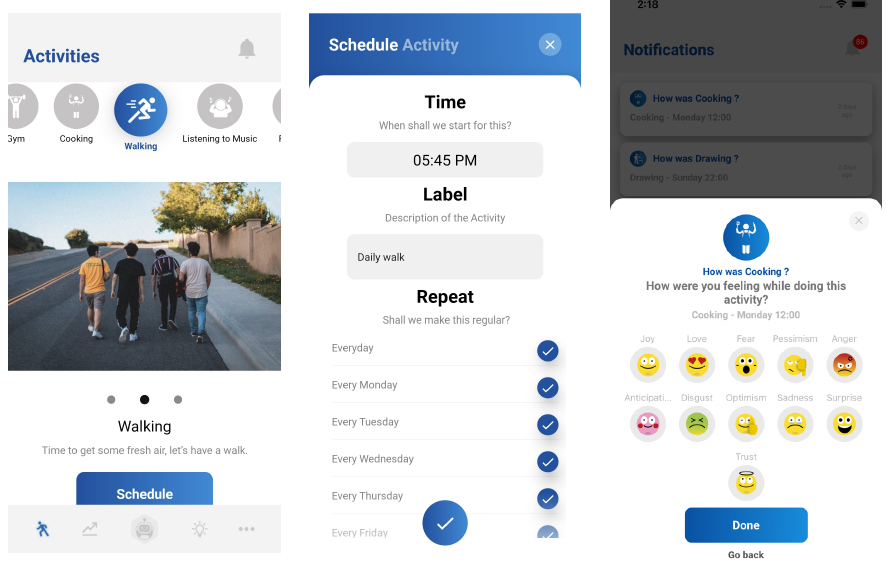
Figure 3. Personalised activity scheduling feature of the